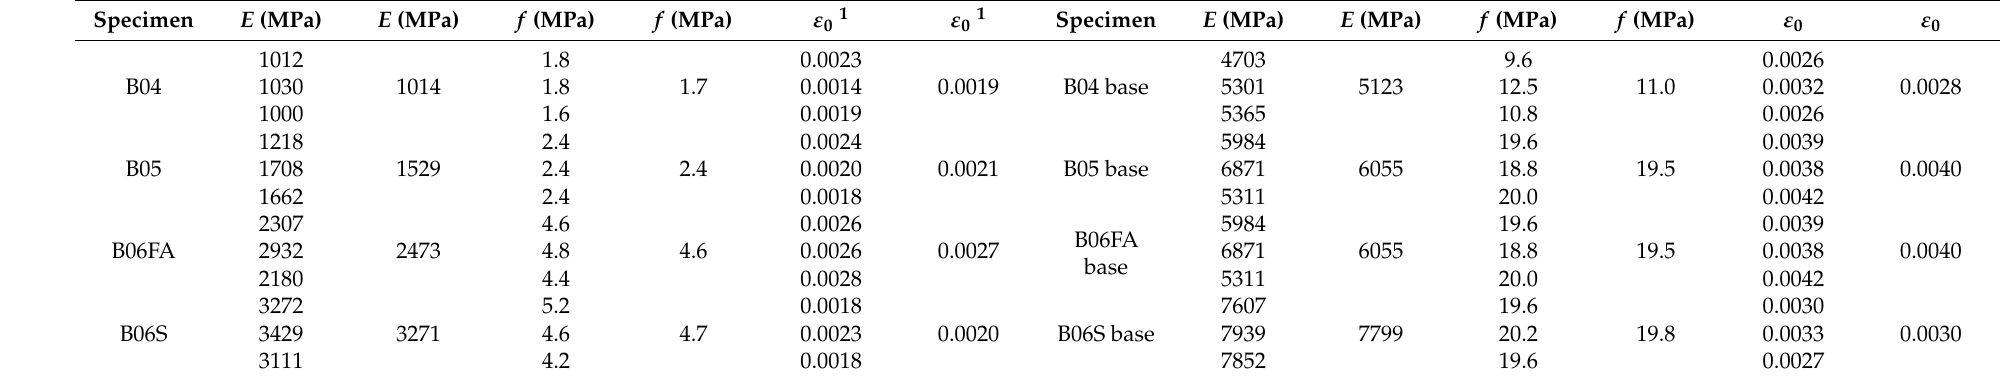
Table 11. Test results of elastic modulus of AAC and base